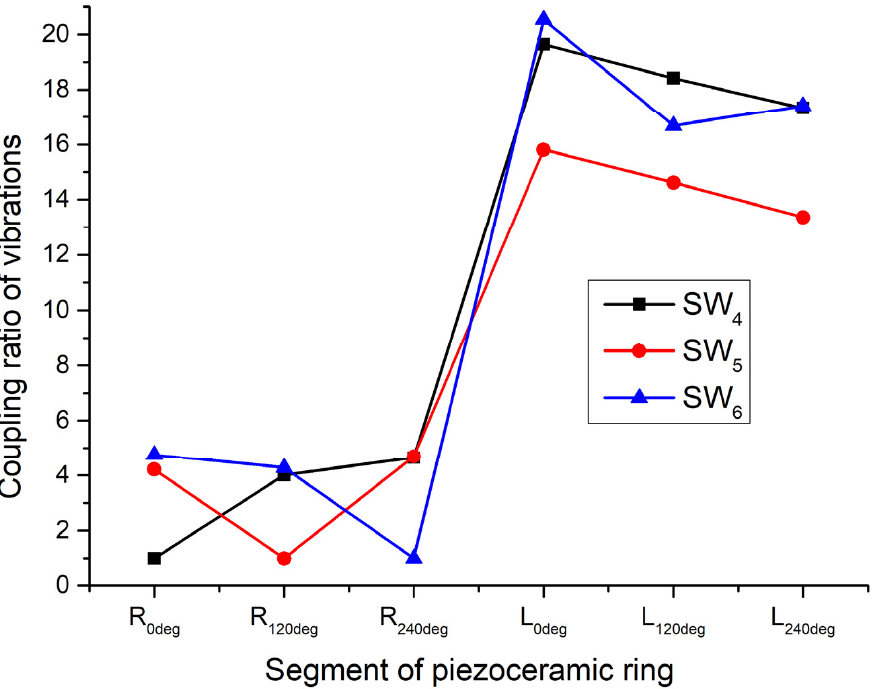
Figure 11. Summary of coupling ratios of vibrations while segments R 0deg –R 240deg of the piezoceramic ring are affected by the excitation signal.